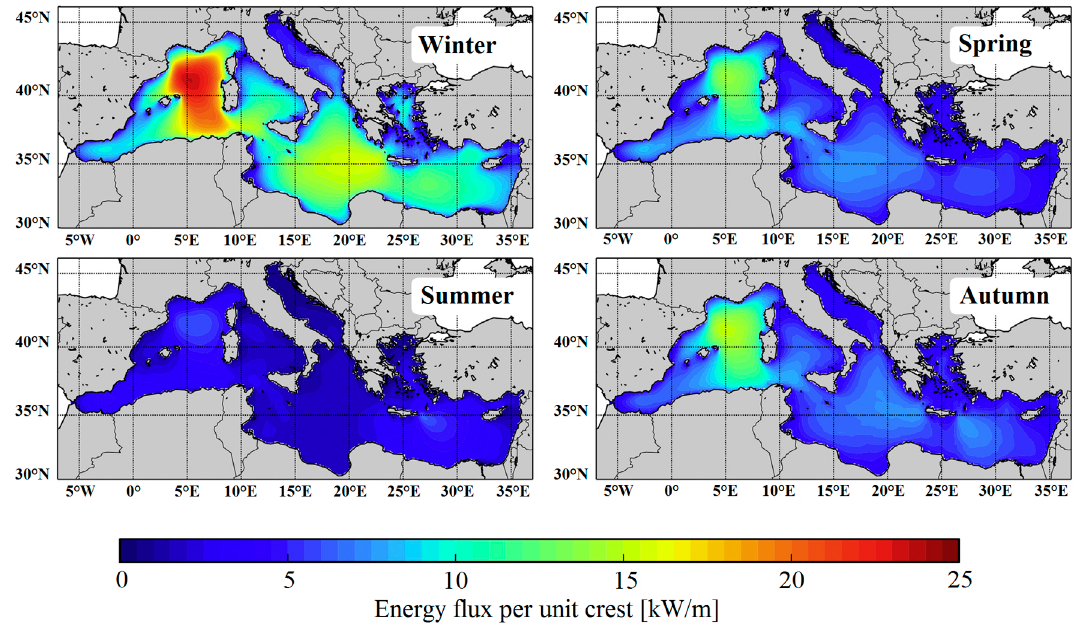
Figure 4. Average seasonal distributions of wave power flux per unit crest in the Mediterranean between 2001 and 2010 [20].